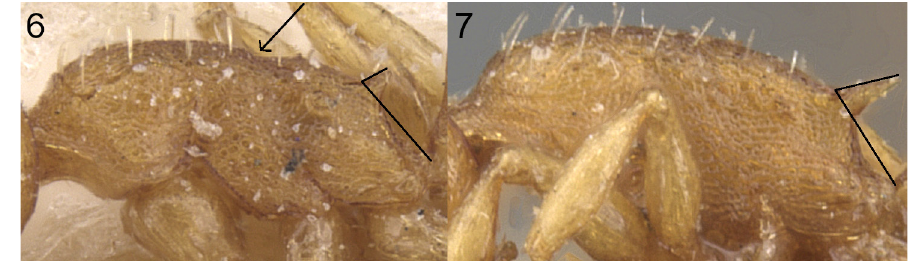
characters, photos by Will Ericson, available on www.antweb.org, specimen identifiers in parentheses. 6 . T. curtulus (Santschi, 1929), type specimen from Morocco (CASENT0912922), metanotal groove present (indicated by an arrow) and short propodeal spines. 7 . T. luteus (Forel, 1874), type specimen from France (CASENT0907603), no metanotal groove and long propodeal spines. Propodeal spines